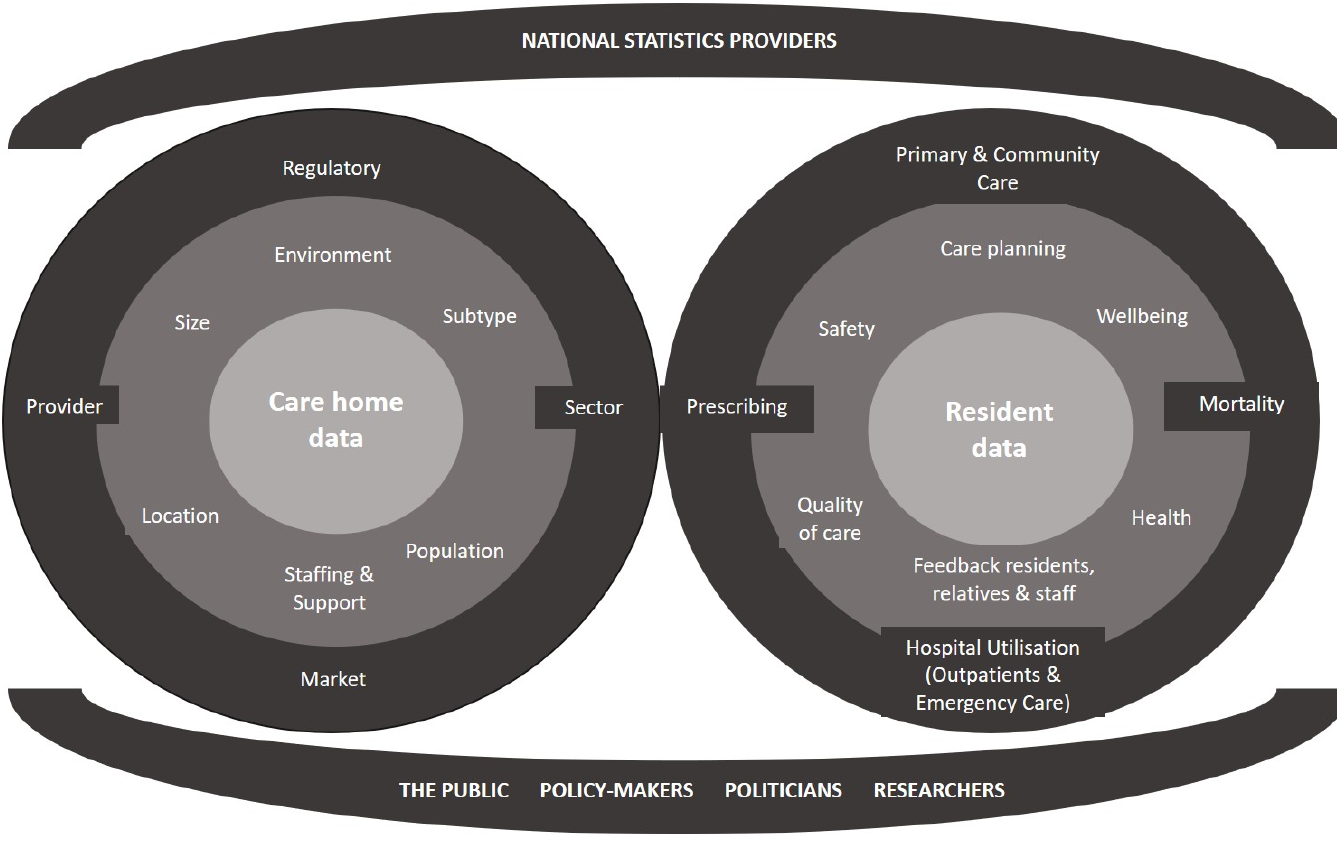
Figure 1: The spectrum of care home and resident data available in the UK and key